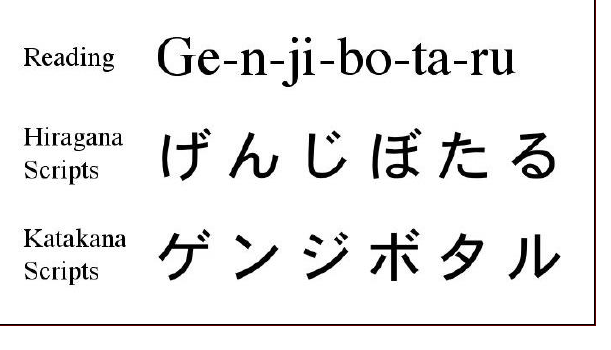
Figure 1. Japanese transcription (Hiragana and Katakana) for the “Genji-botaru” (Genji-firefly, Luciola cruciata